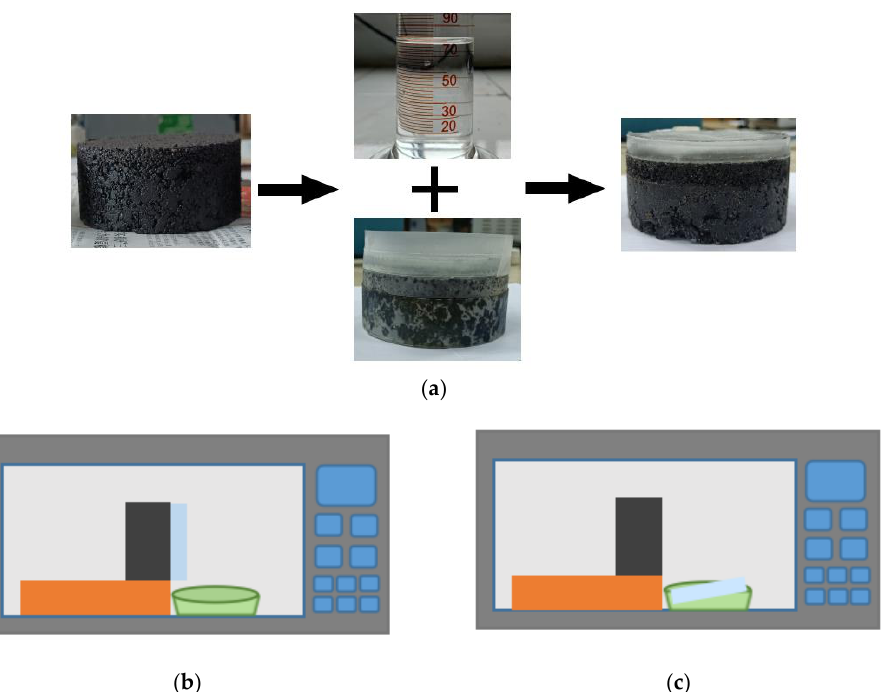
Figure 4. The process of microwave deicing test: ( a ) ice layer preparation; ( b ) ice layer melting; ( c ) ice layer falling off.